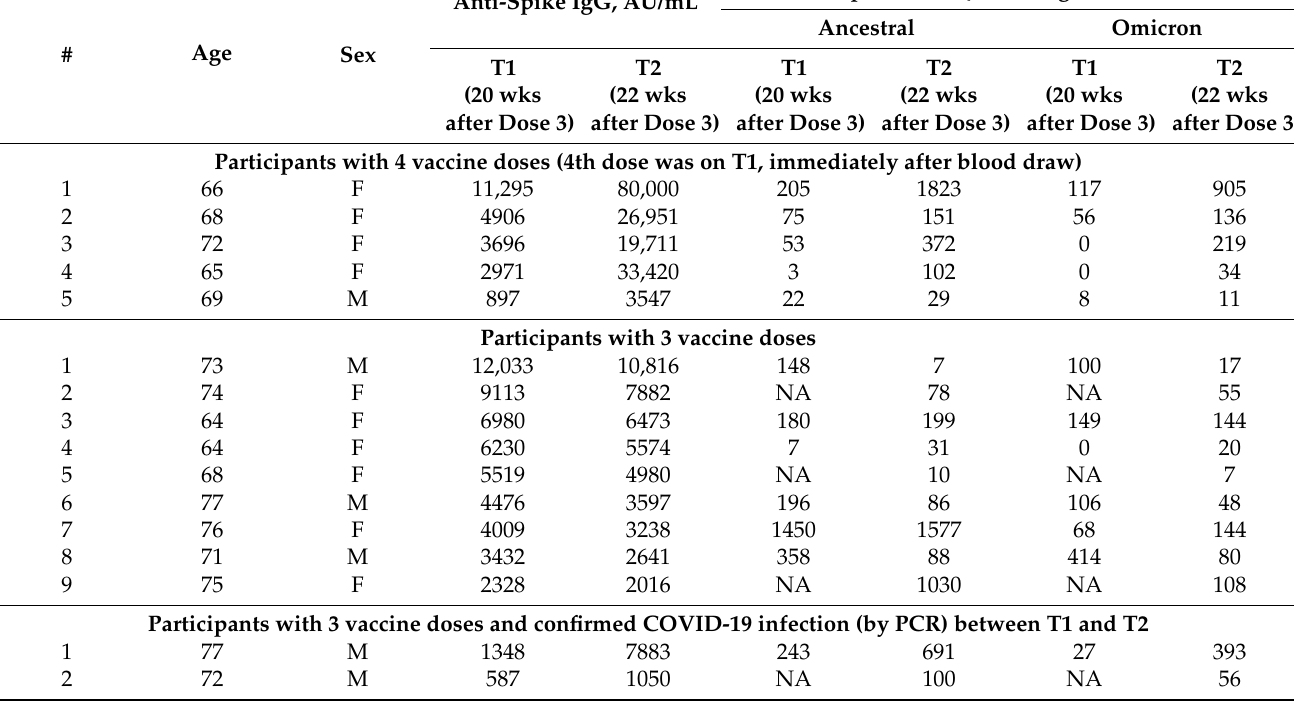
Table 1. Anti-spike IgG titers and T-cell response in participants who received 3 or 4 BNT162b2 vaccine